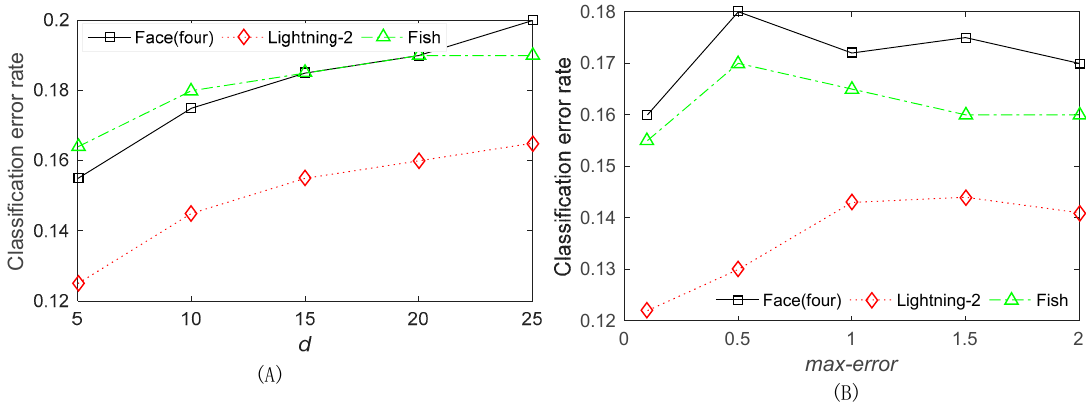
Figure 5. The trends comparison of the classification error rate under different parameters. ( A ) max_error is fixed and d is variable; ( B ) d is fixed and max_error is variable.